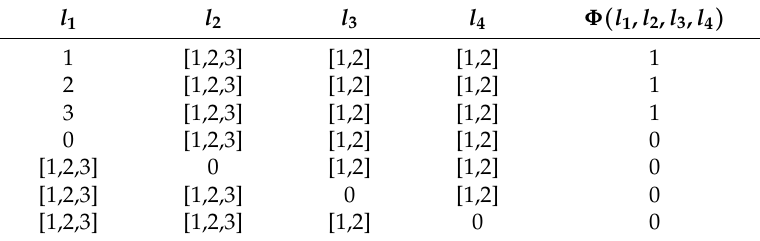
Figure 10. Reliability block diagram of load-sharing systems. Table 2. Survival signature of the wind turbine